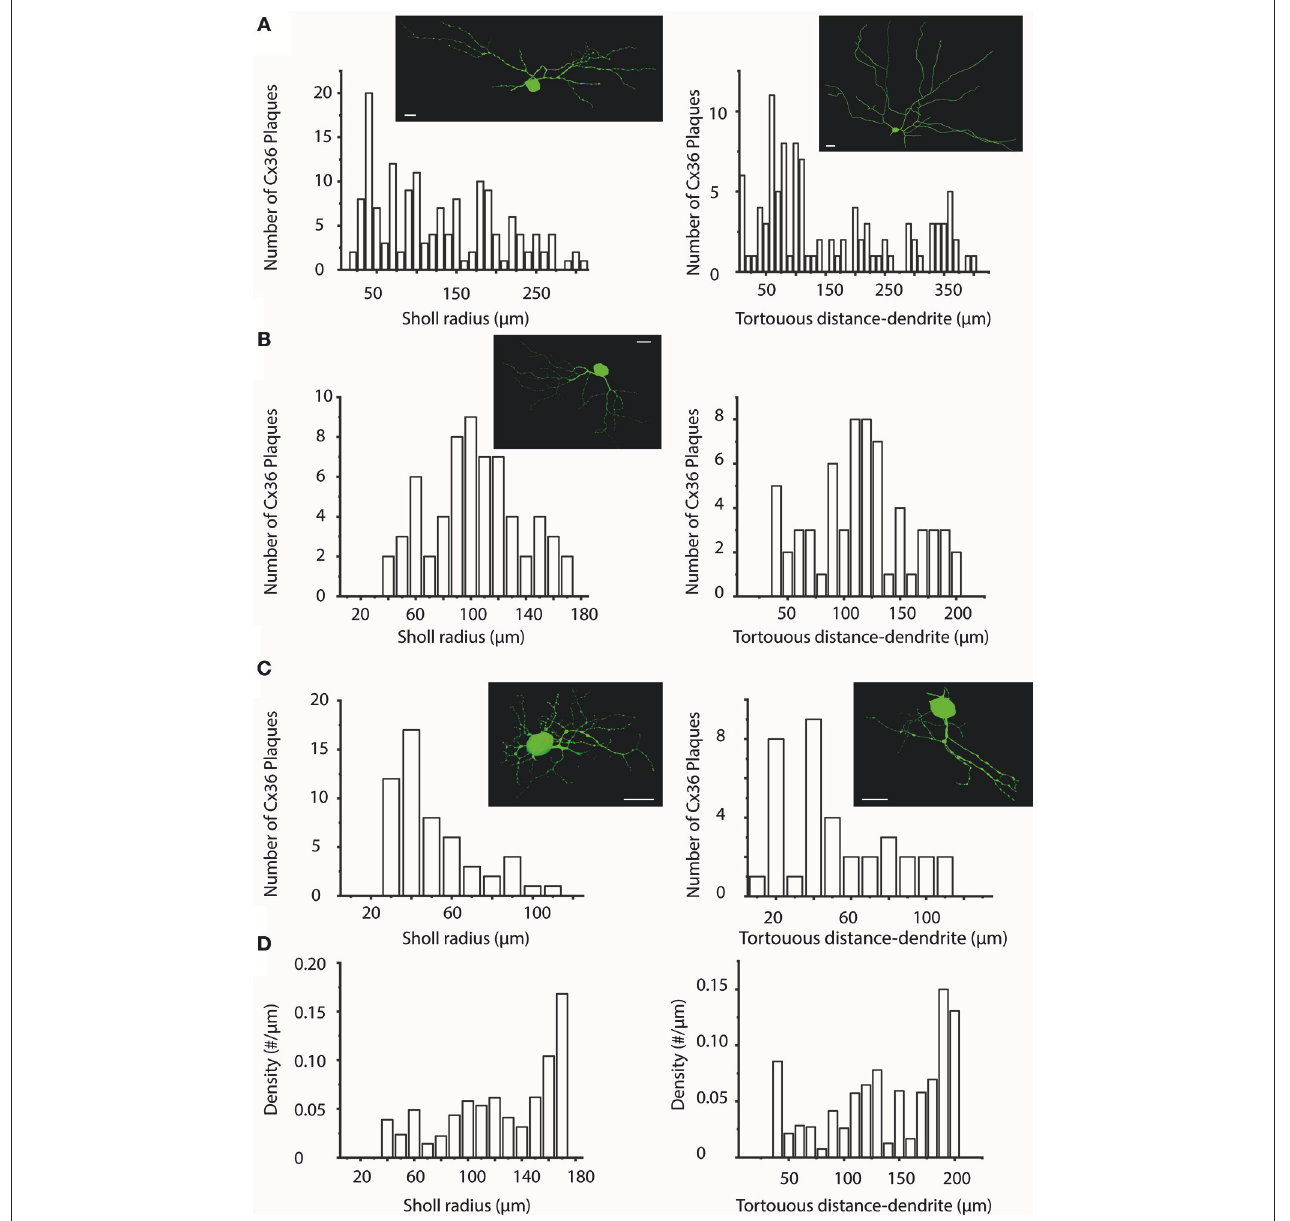
FIGURE 4 | Sholl- and Tortuous Distance Analyses of Cx36 plaques over hRGC dendritic arbors. (A–C) Sholl (left panels) and Tortuous Distance (right panels) analyses shown for representative hRGCs (top, middle, and bottom) to visualize the Cx36 plaque distribution as a function of distance (10 µ m bins) to the soma. As our sample contained many different hRGC subtypes we found plaque distributions with very different patterns including those appeared random ( A,C right), showing near Gaussian shape (B) , descending ( C left). These analyses thus did not seem to reveal preferred dendritic locations for Cx36 plaques that are general features for the entire examine hRGC population. Images on the top of each panel display a representative hRGC. Note, that both left and right panels in b display histograms of the same hRGC. (D) Due to the fact that actual dendritic segment numbers and lengths may differ considerably in each step window, the plaque density was also plotted against both the Sholl (left) and the Tortuous Distance (right) radii. The two panels in (D) shown here were generated on the dataset for the hRGC shown in (B) . These graphs clearly show in both the Sholl and the Tortuous Distance Analyses that the distalmost bins display the highest plaque density, suggesting that dendritic terminal endings bear a special importance. Scale bars: 25 µ